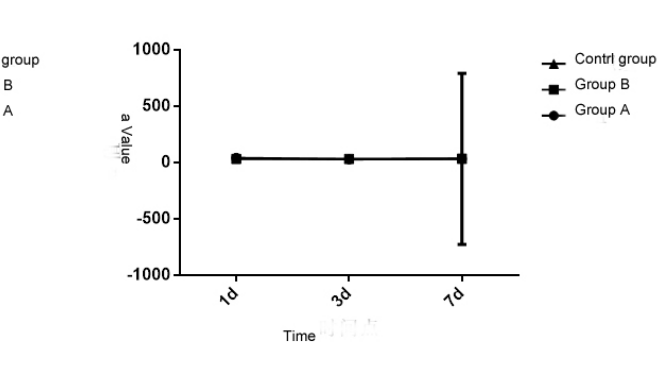
Figure 2: Comparative analysis of m value of the patients in the three groups at different